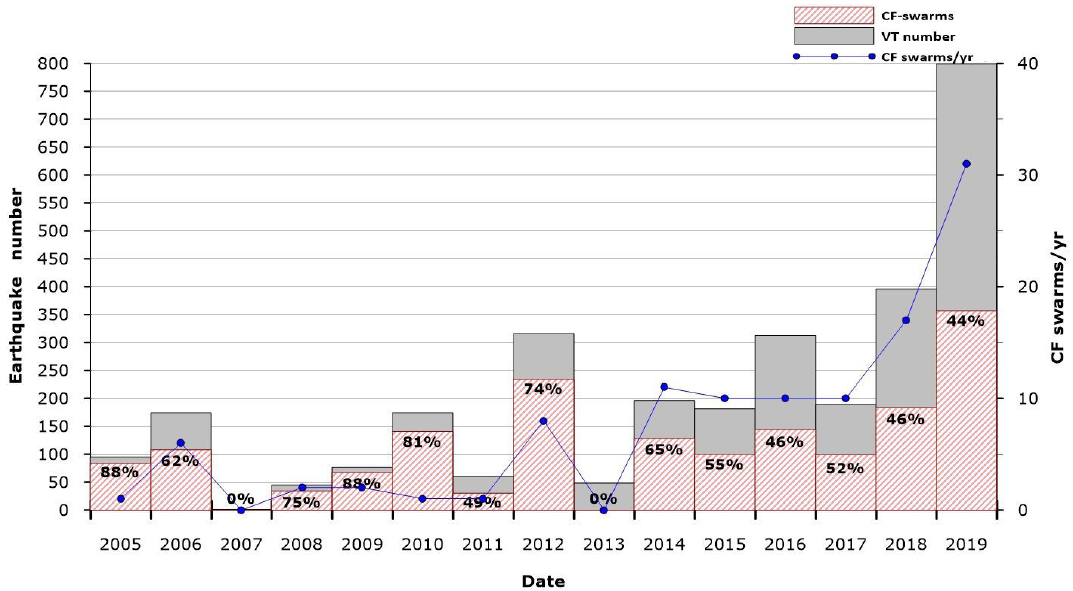
Figure 7. Annual distribution of all the VTs (gray), the VTs of the CF-swarm (red dashed), the number of CF-swarms per year (blue line) and the percentage of VTs of the CF-swarms respect to the number of all the VTs (percentage number) since 2005 to